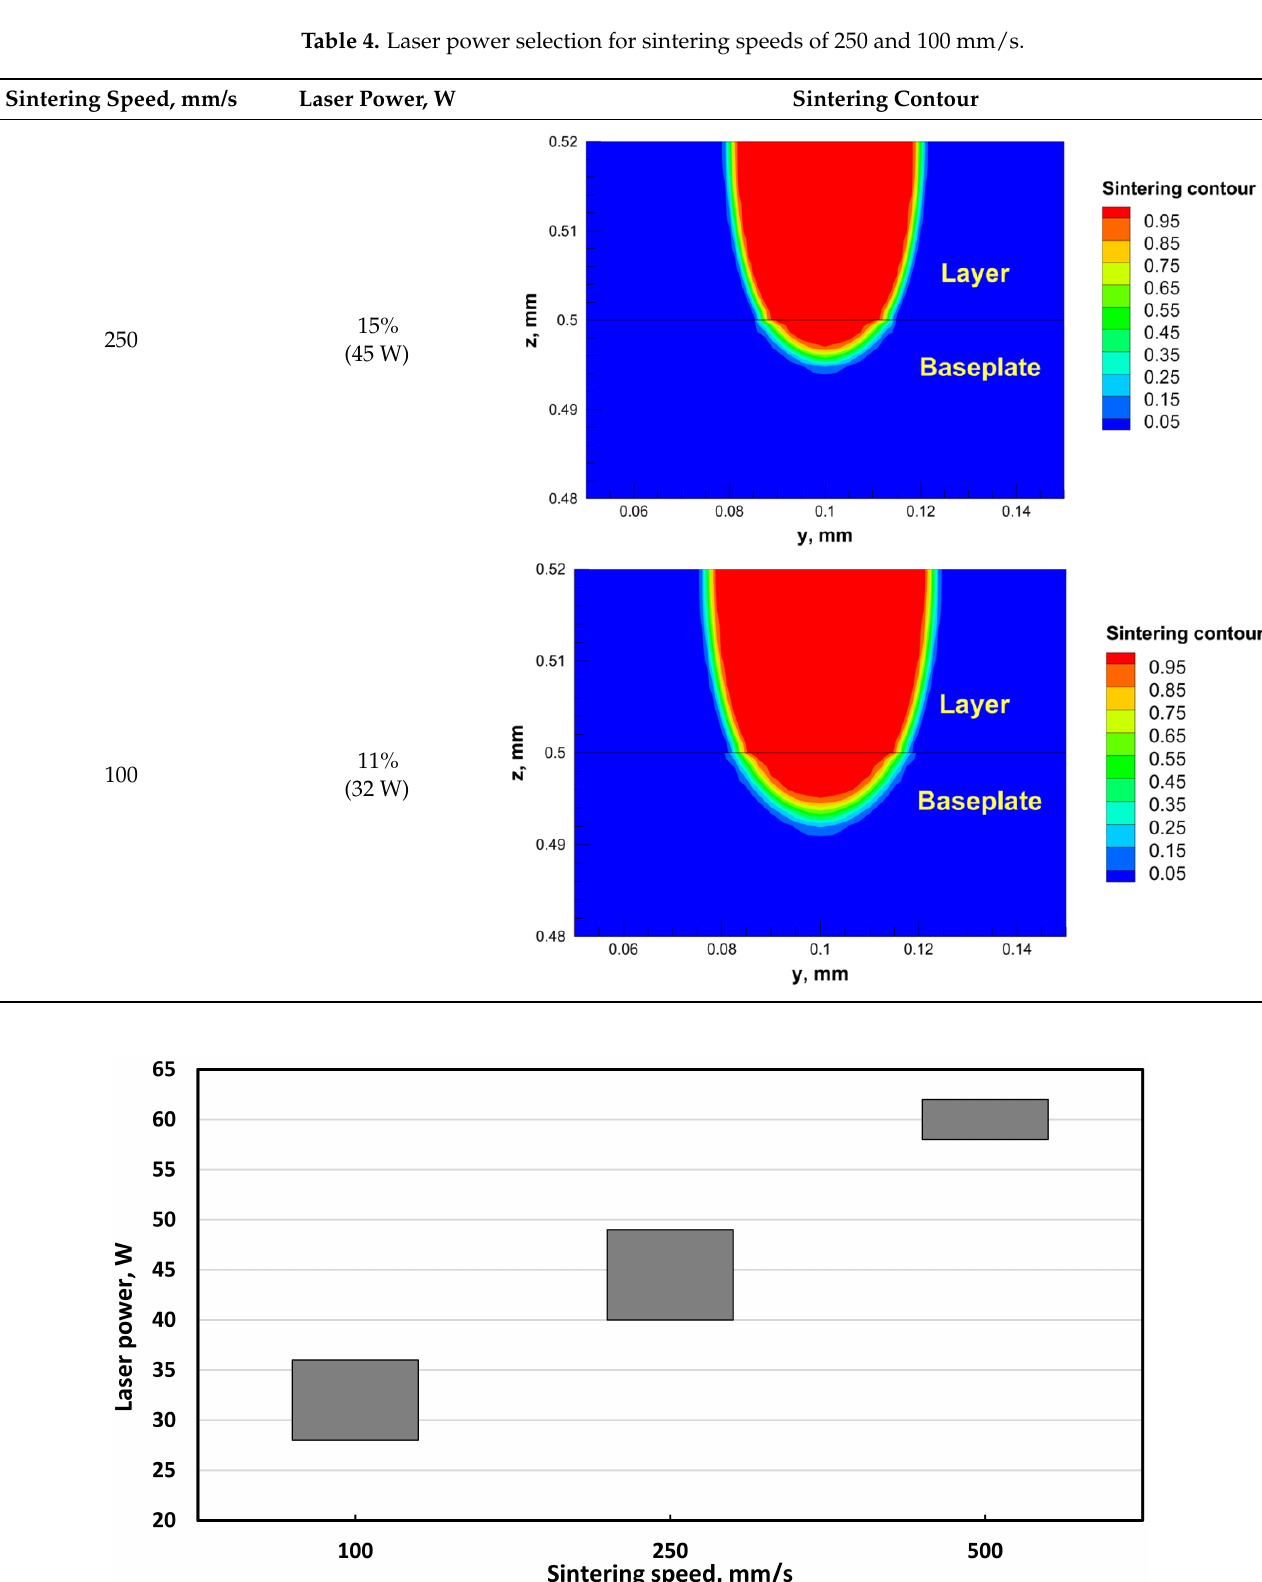
Figure 9. Laser power range with sintering speeds of 500, 250, and 100 mm/s (layer thickness 22 µm).